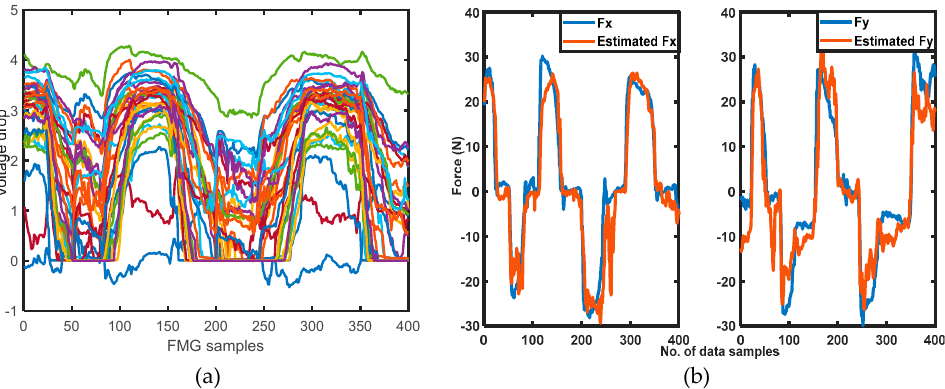
Figure 6. Target dataset 1 used in SDA: ( a ) target test FMG data; ( b ) true forces and estimated forces in X and Y dimensions estimated by the retrained SFMG-DTL learner.